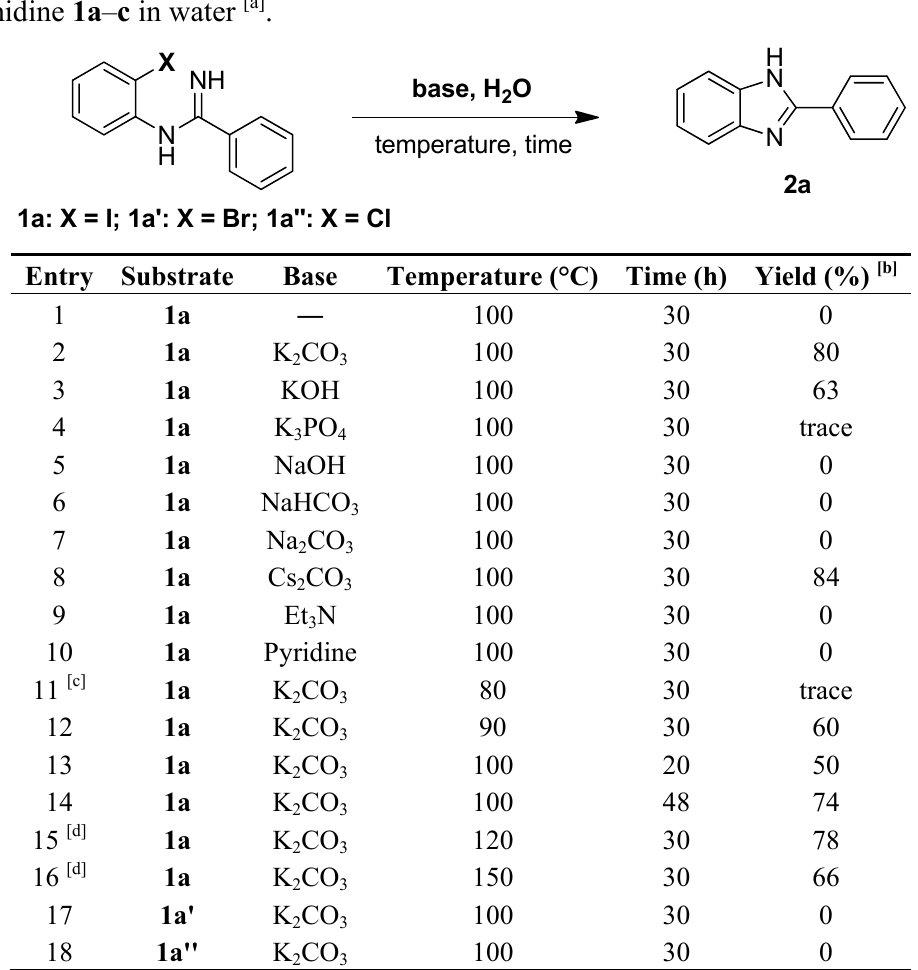
Table 1. Optimization of base-mediated intramolecular C–N cross-coupling